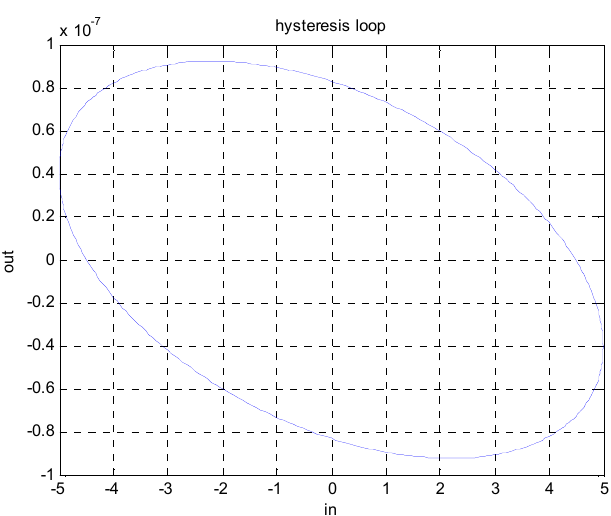
Figure 6. History of input voltage and output displacement for the driven piezoelectric material.